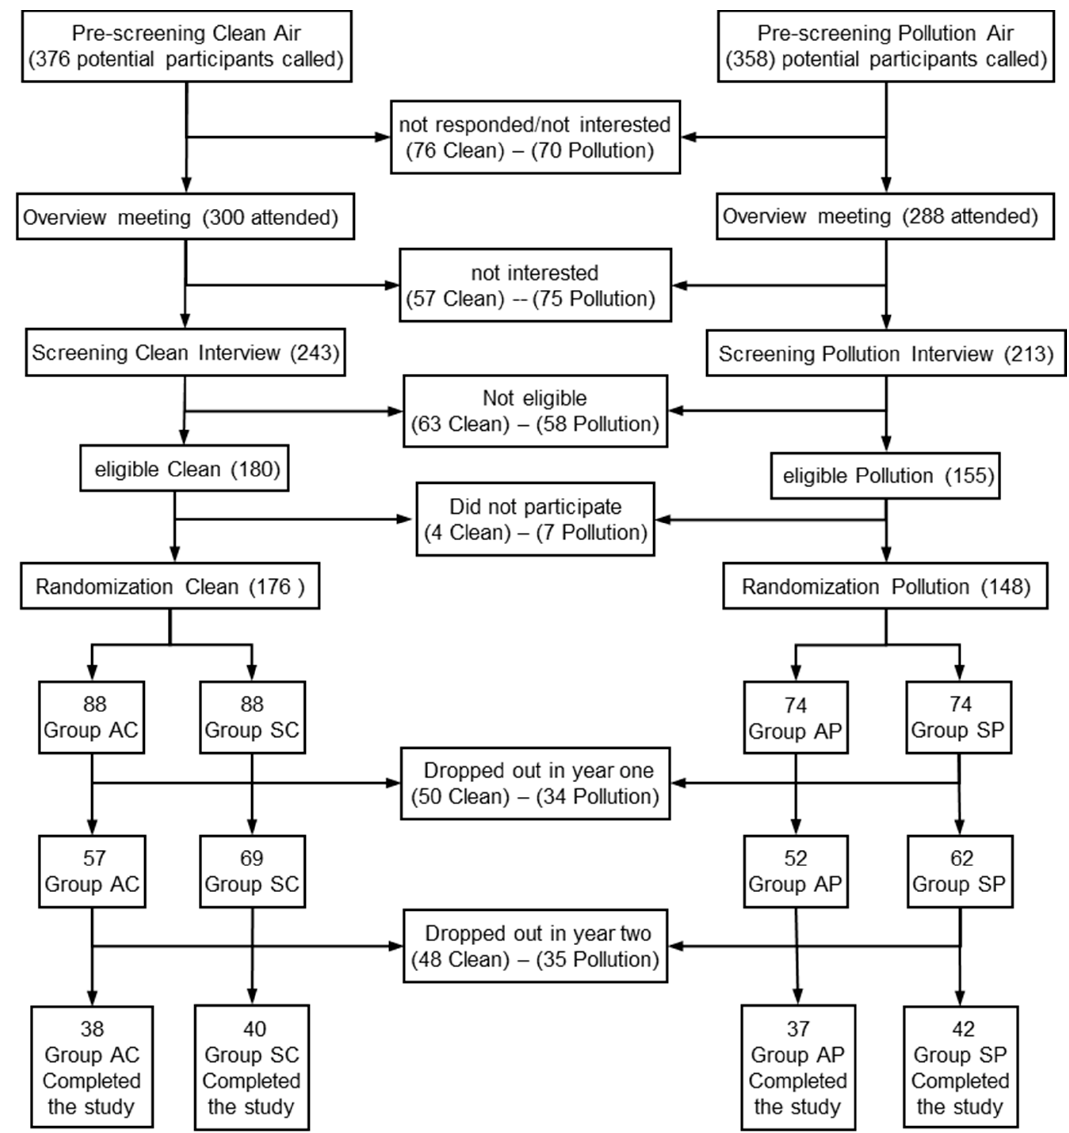
Figure 1. Sequence for recruitment screening. Group AC (Physical Activity and Clean Air). Group AP (Physical Activity and Polluted Air). Group SC (Sedentary and Clean Air). Group SP (Sedentary and Polluted Air).